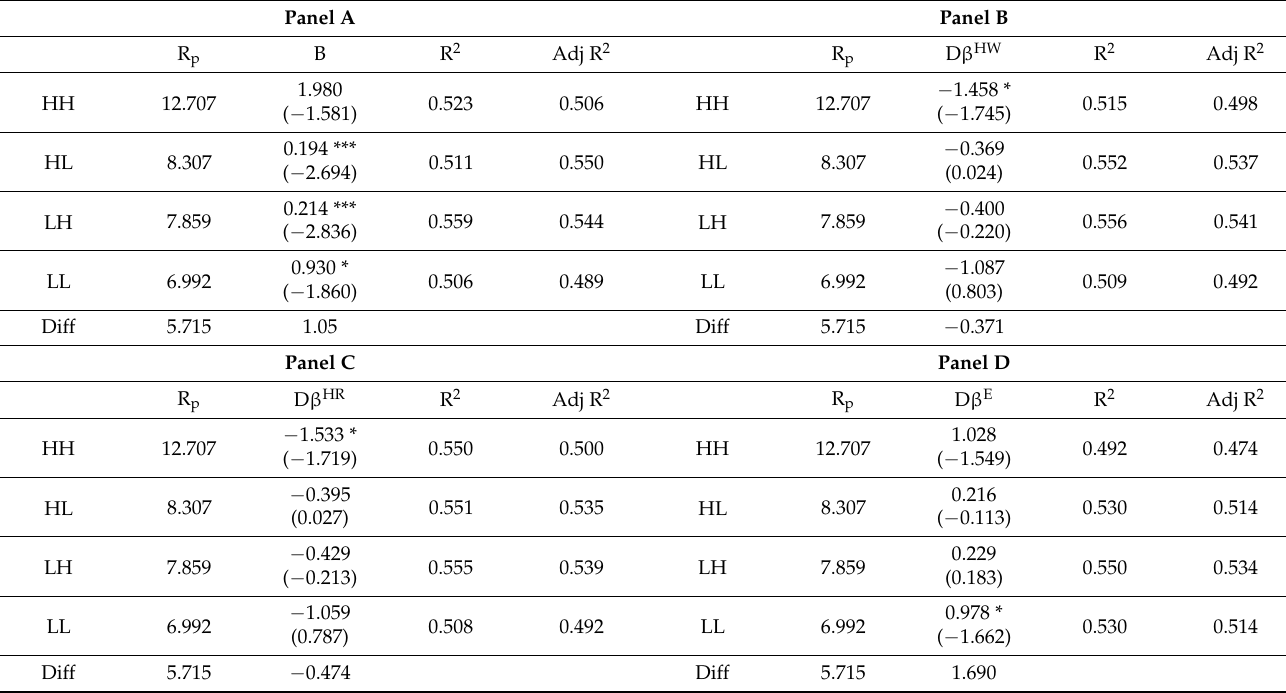
Table 1. Results for β , D β HW , D β HR , and D β E with R 2 and Adj R 2 and their t -stat in ( ). Diff is the difference of returns between HH and LL for β , D β HW , D β HR , and D β E showing the risk–return relationship.